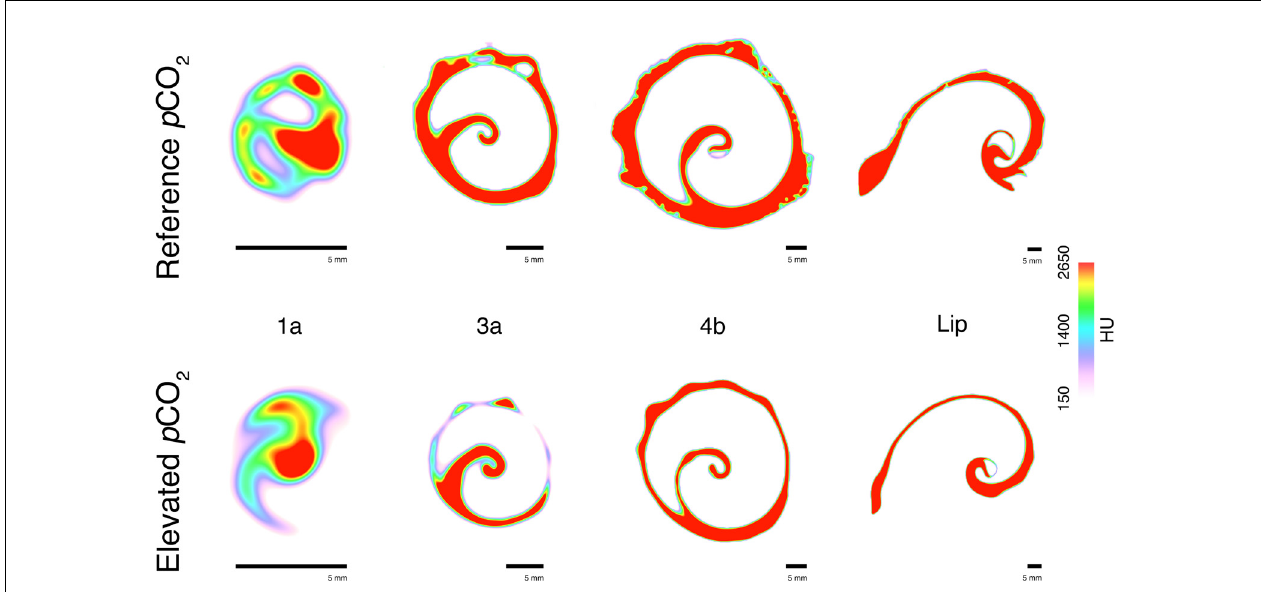
FIGURE 4 | Representative example of the identified cross-section slices from the computed tomography (CT) scanning from different shell regions (1a, 3a, 4b, and shell lip) collected from the reference p CO 2 (Upper) and elevated p CO 2 (Lower) sites. Colour scale indicates density (Hounsfield unit, HU) with warmer colours indicating higher density and cooler colours a lesser